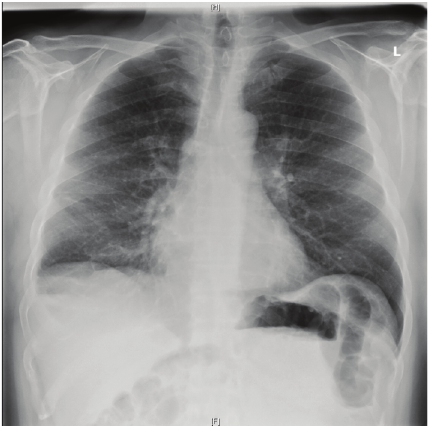
Figure 1: Large pleural effusion in the right hemithorax with probable collapse of right middle and lower lung lobes.